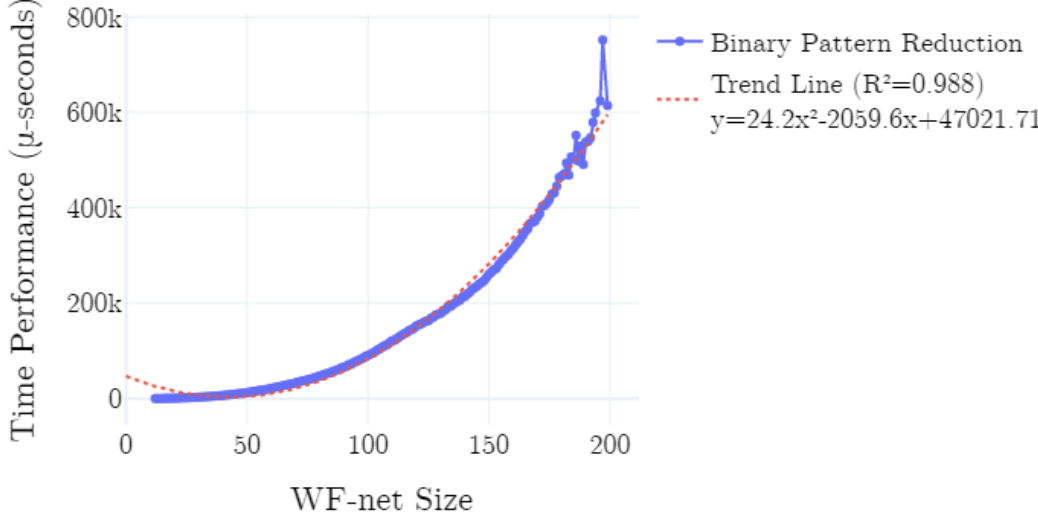
Figure 14. Average time performance of the implementation. A quadratic relation, in computation time measured in micro-seconds ( µ -seconds), with respect to the size of the WF-net, is